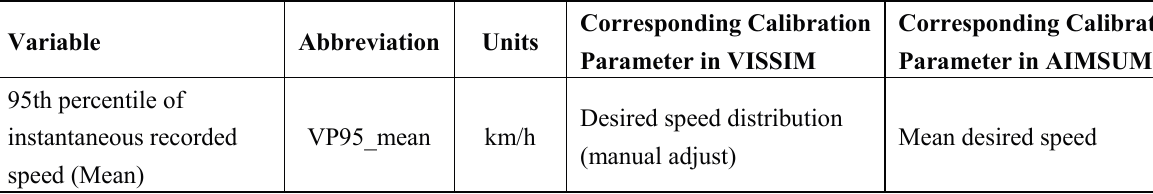
Table 2. Variables extracted from the recorded driving profiles and their correspondence with VISSIM and AIMSUM